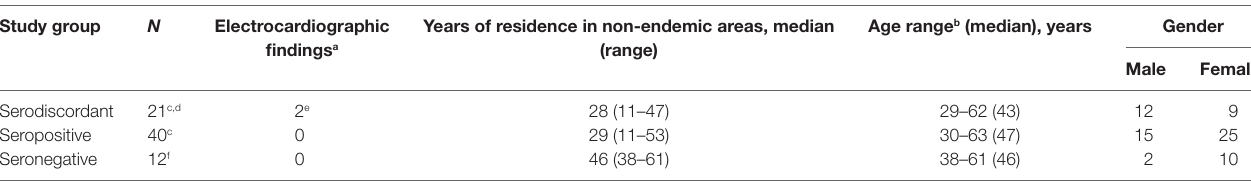
TaBle 1 | Characteristics of study